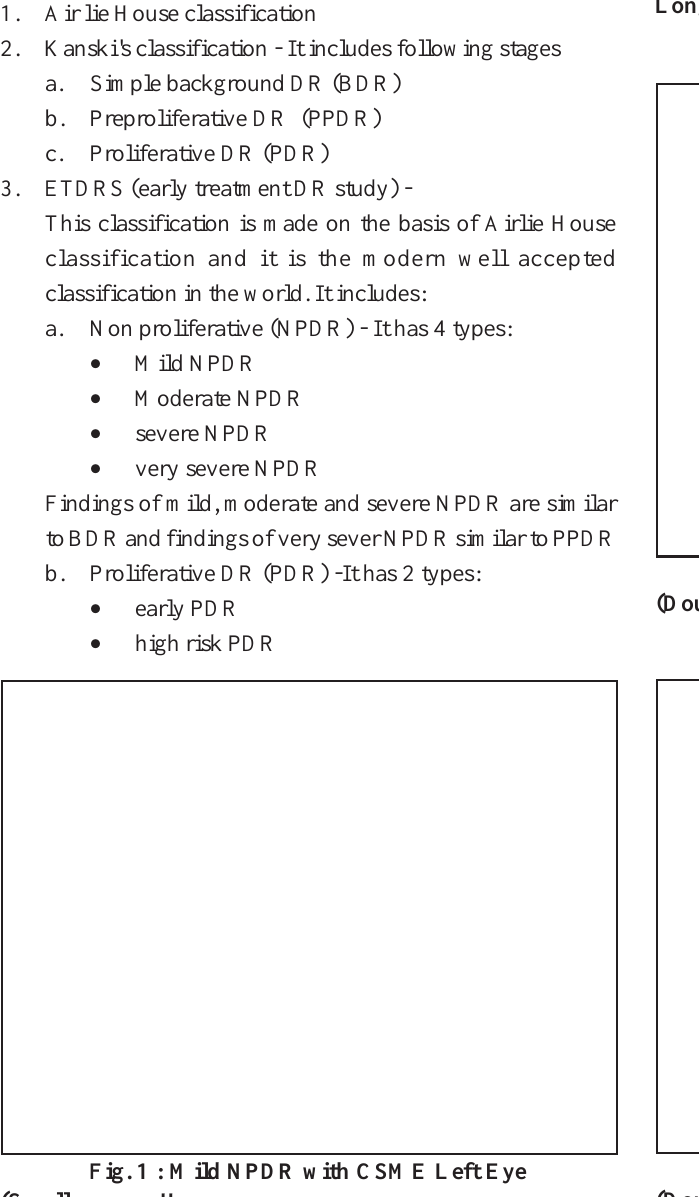
Fig. 4 : Very severe NPDR (Double arrow - Venus